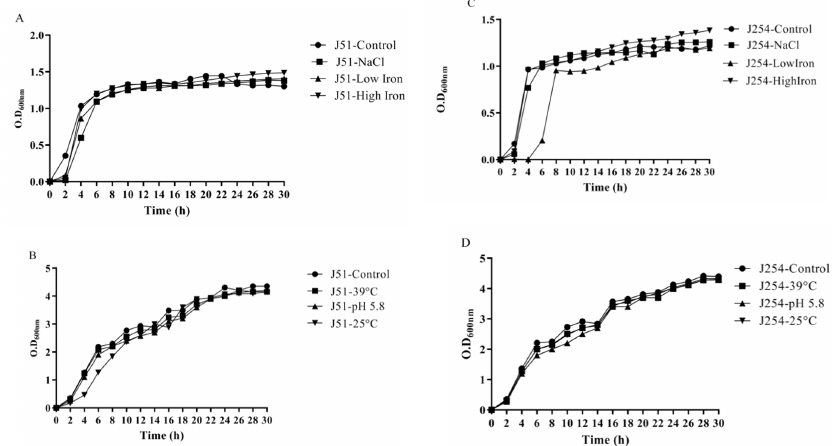
Figure 1. Growth kinetics of MDR E. coli J51 ( A and B ) and J254 ( C and D ) under control and in vitro gut conditions. Unpaired t -test was performed and p < 0.05 was considered significant. ( A ) Effect of NaCl, low and high iron on growth kinetics of MDR isolate (J51), ( B ) Effect of high temperature, pH, low temperature on growth kinetics of MDR isolate (J51), ( C )Effect of NaCl, low and high iron on growth kinetics of sensitive isolate (J254), ( D ) Effect of high temperature, pH, low temperature on growth kinetics of sensitive isolate (J254).